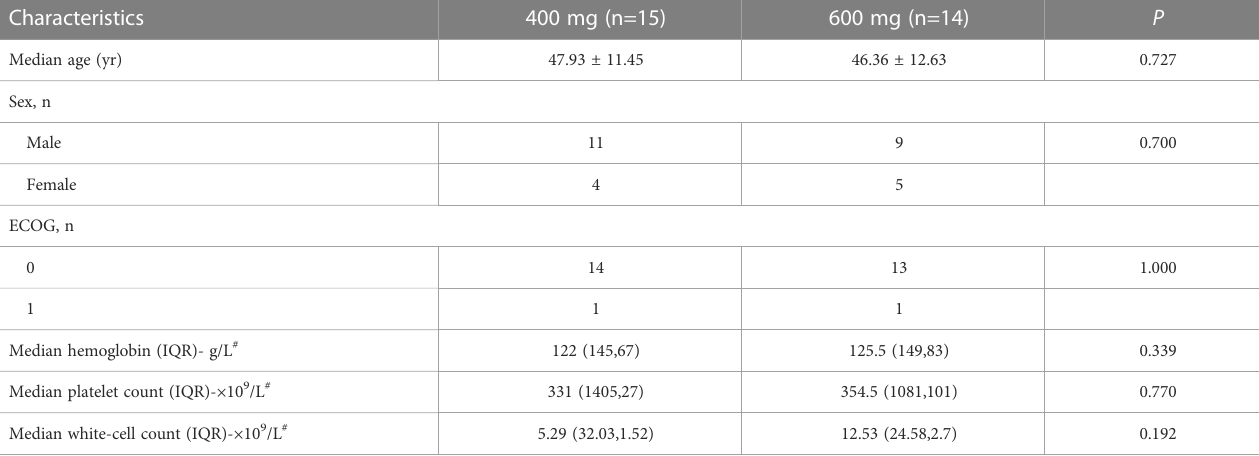
TABLE 1 Demographic characteristics and baseline information of patients.